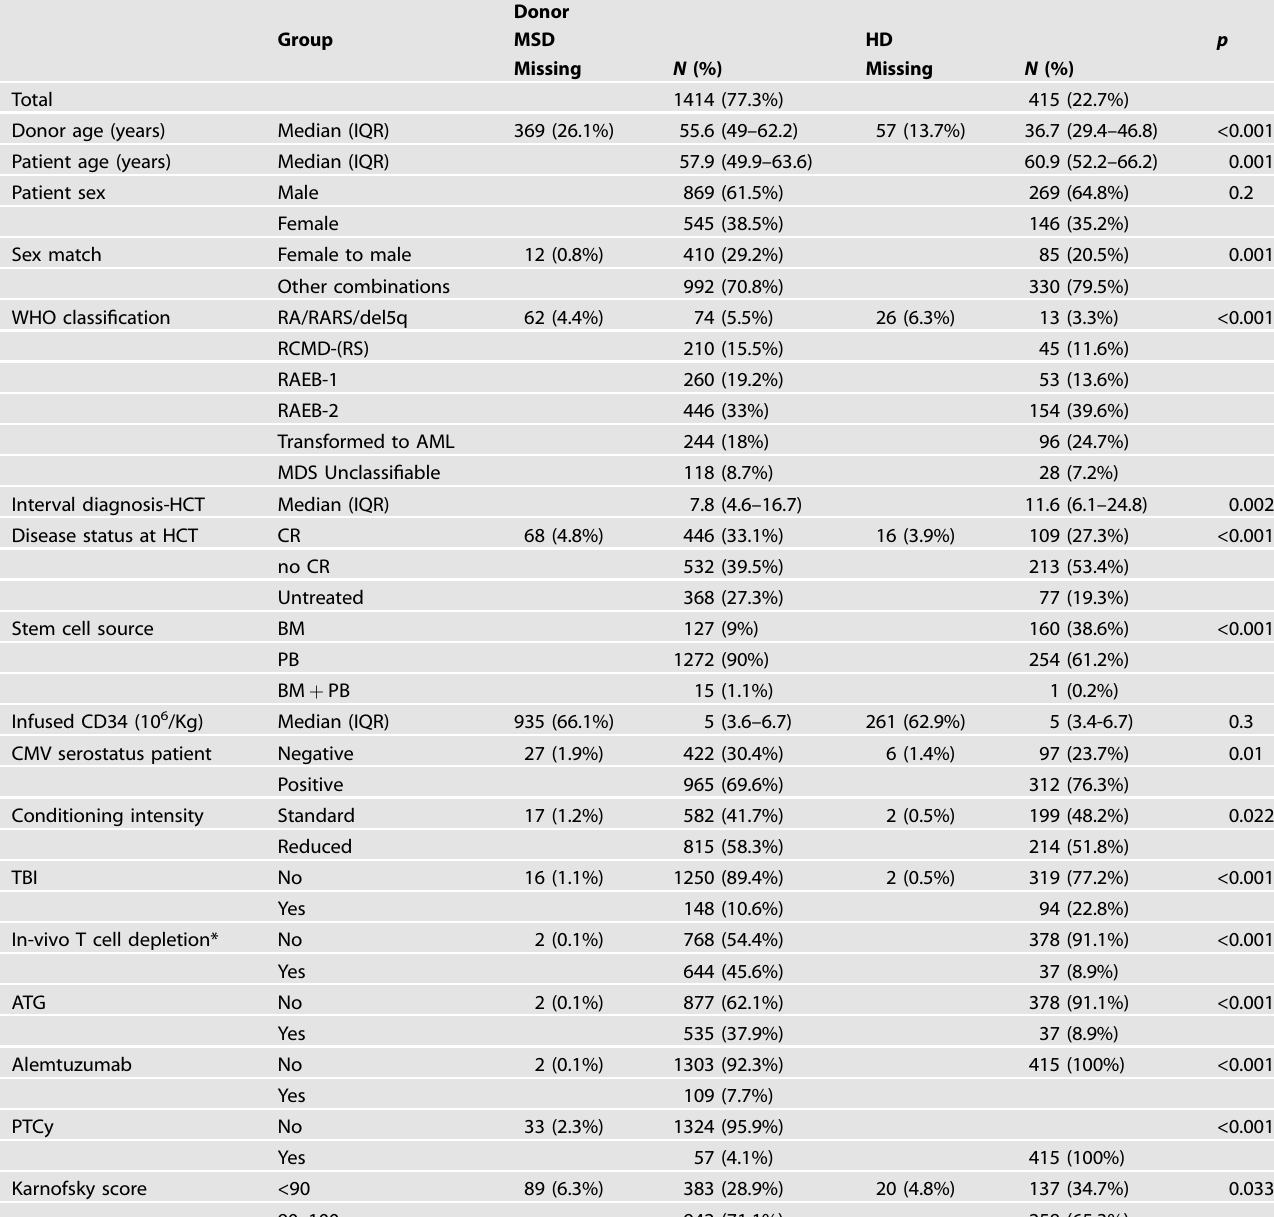
Table 1. Demographic pro fi le of